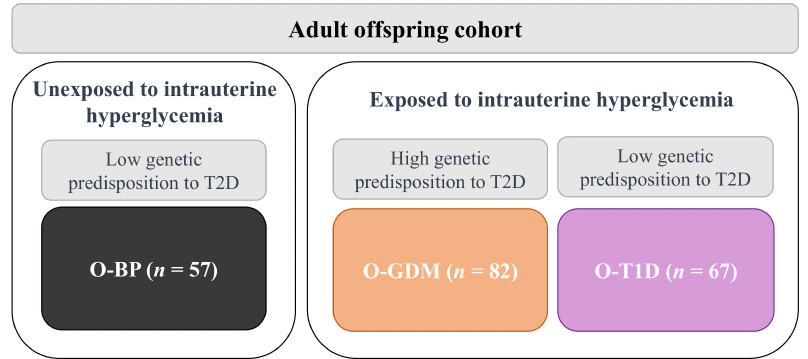
Figure 1. Overview of the adult offspring cohort analyzed in the present study. O-GDM: offspring of women with GDM, O-T1D: offspring of women with T1D, O-BP: offspring of women from the background population, T2D: type 2